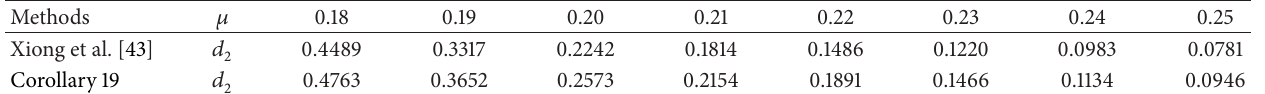
Table 6: Maximum upper bound of 𝑑 2 with Π 1 and different parameter 𝜇